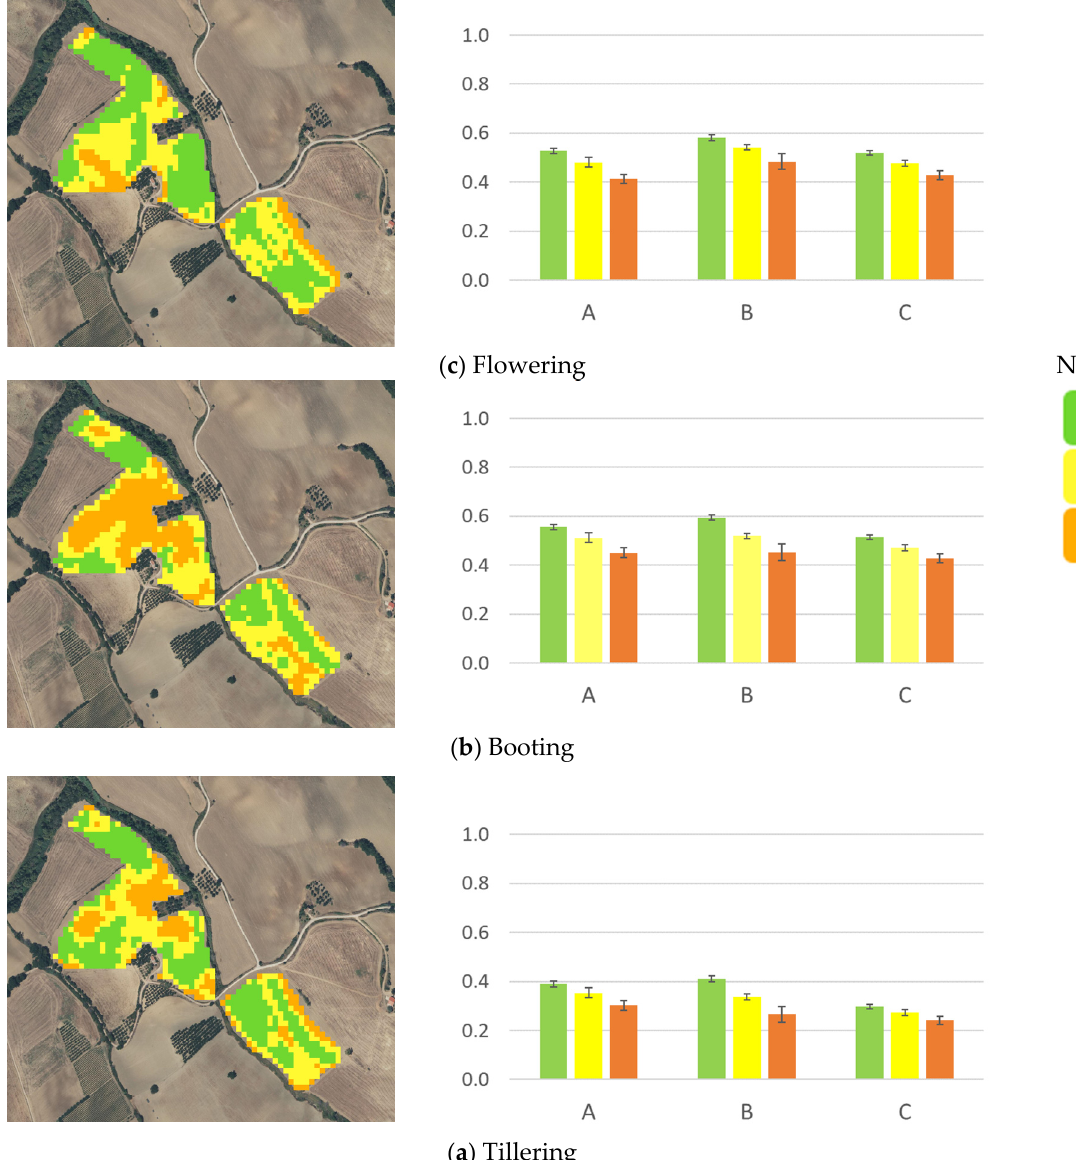
Figure 6. NDVI derived from the Sentinel-2 images and clusters’ map (sx) and NDVI data of combined cluster and landscape position (dx) with high, medium, and low subfield areas at ( a ) tillering, ( b ) booting, ( c ) flowering, and ( d ) milk development Zadok’s stages.